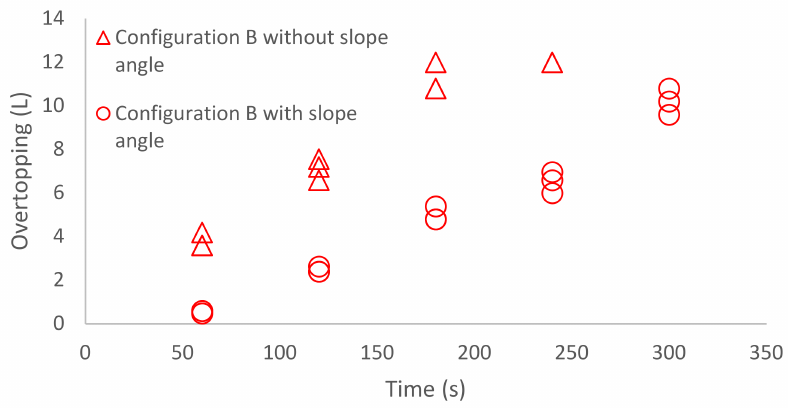
Figure12. PerformanceofConfigurationAwithandwithoutslopeangleforJONSWAPhydraulicconditions.